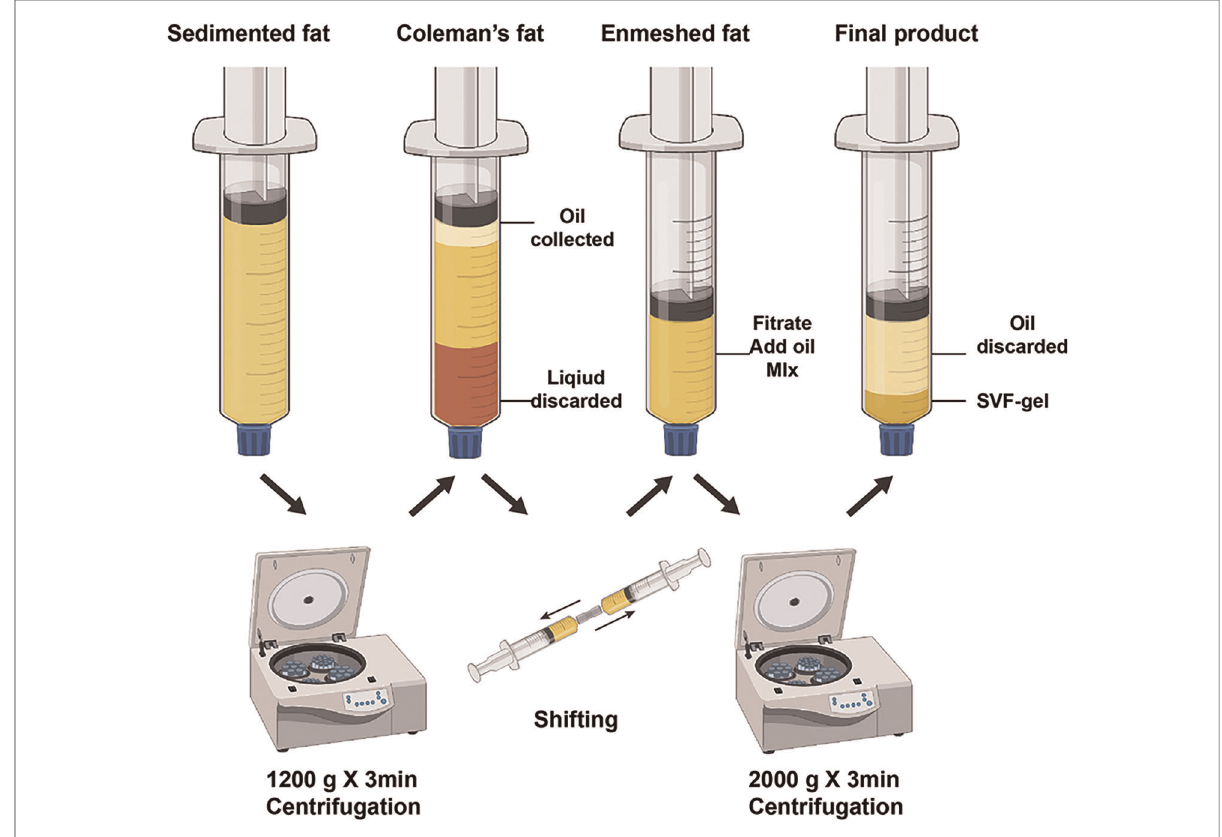
FIGURE 1 Processing procedure for